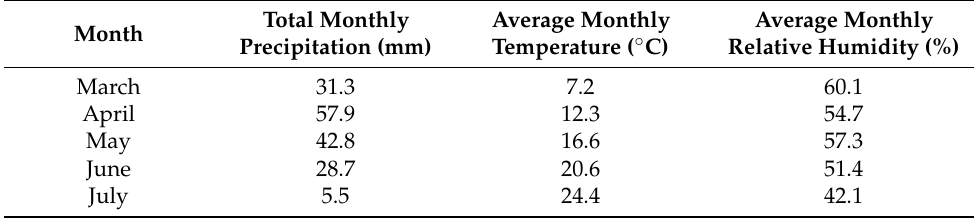
Table 1. Basic weather data during the experiment.